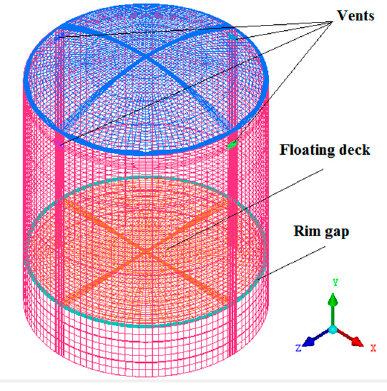
Figure 3. Grid model for the IFRT.